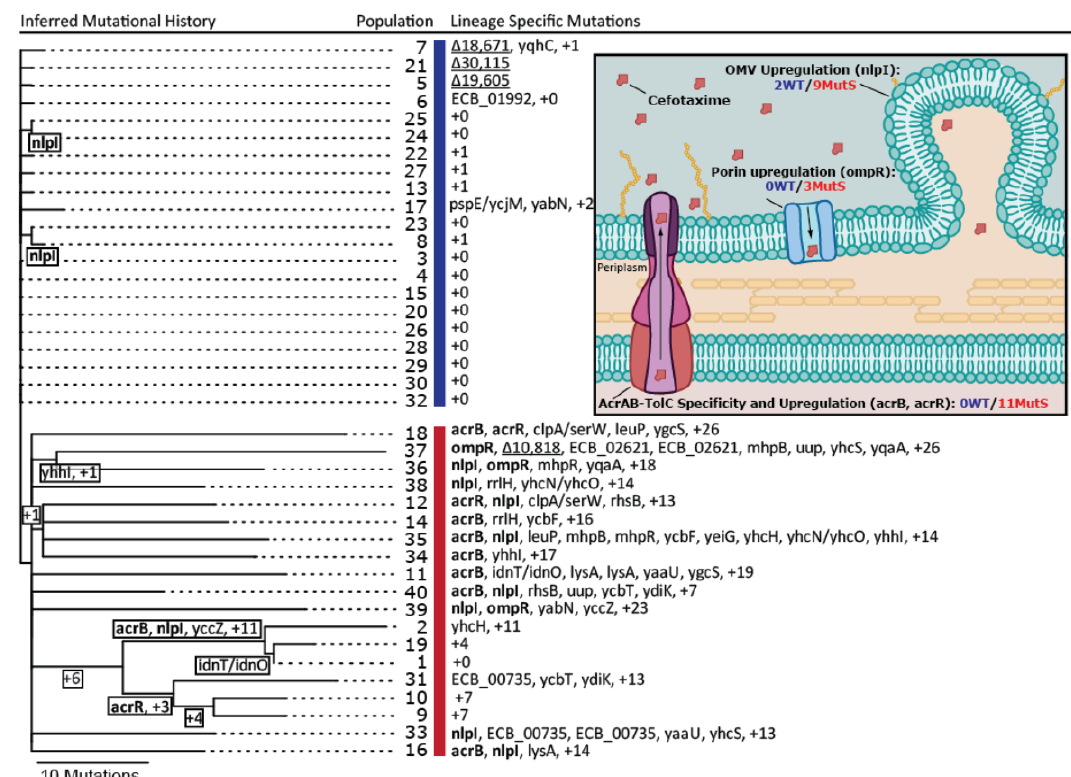
Figure 2. Inferred phylogenetic tree of the 40 sequenced end clones. Only parallel mutations that occurred in at least two clones independently are shown by their gene name. Mutations that occurred at least two times independently in known resistance genes are highlighted in bold. The recurring IS1-mediated deletion, starting at cybB, is underlined. Intergenic mutations are indicated by a slash in between the two genes surrounding this mutation. WT clones are indicated by the blue vertical bar, MutS clones by the red bar. The inset shows the cefotaxime resistance mechanisms identified in the evolved clones and the total number of mutations in each resistance mechanisms in WT and MutS clones. The named genes in brackets show the main genes mutated for each mechanism. OMV: outer-membrane